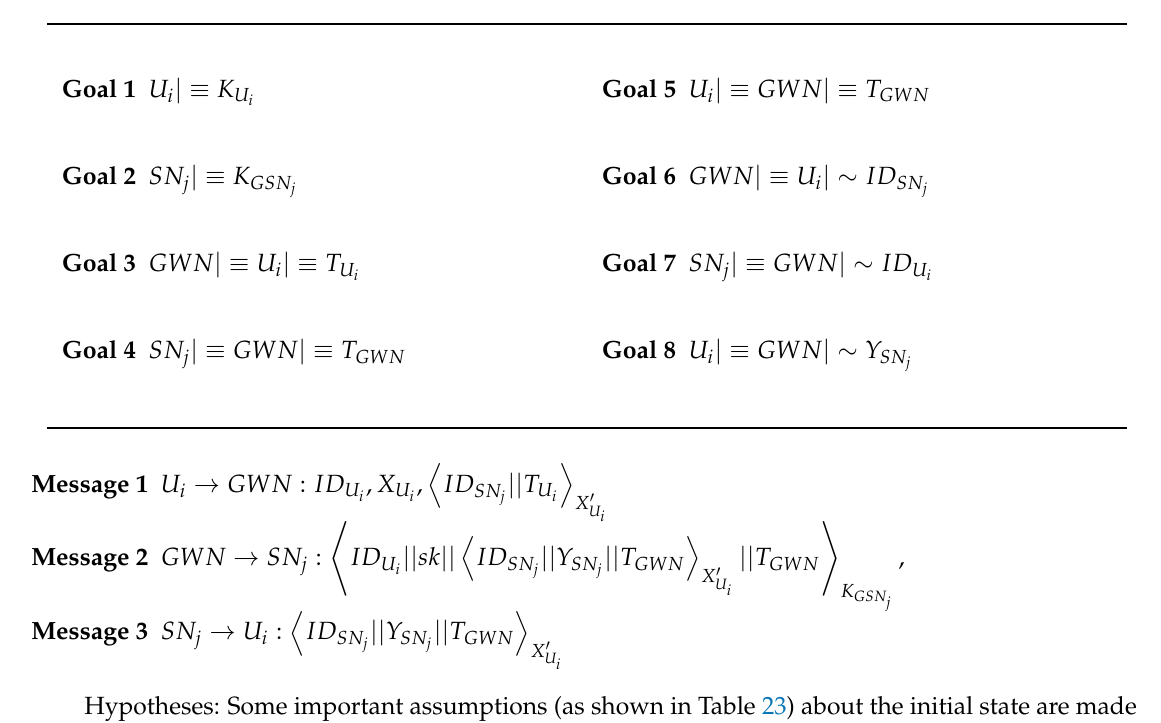
Table 22. Goals: The goals made to analyze the proposed